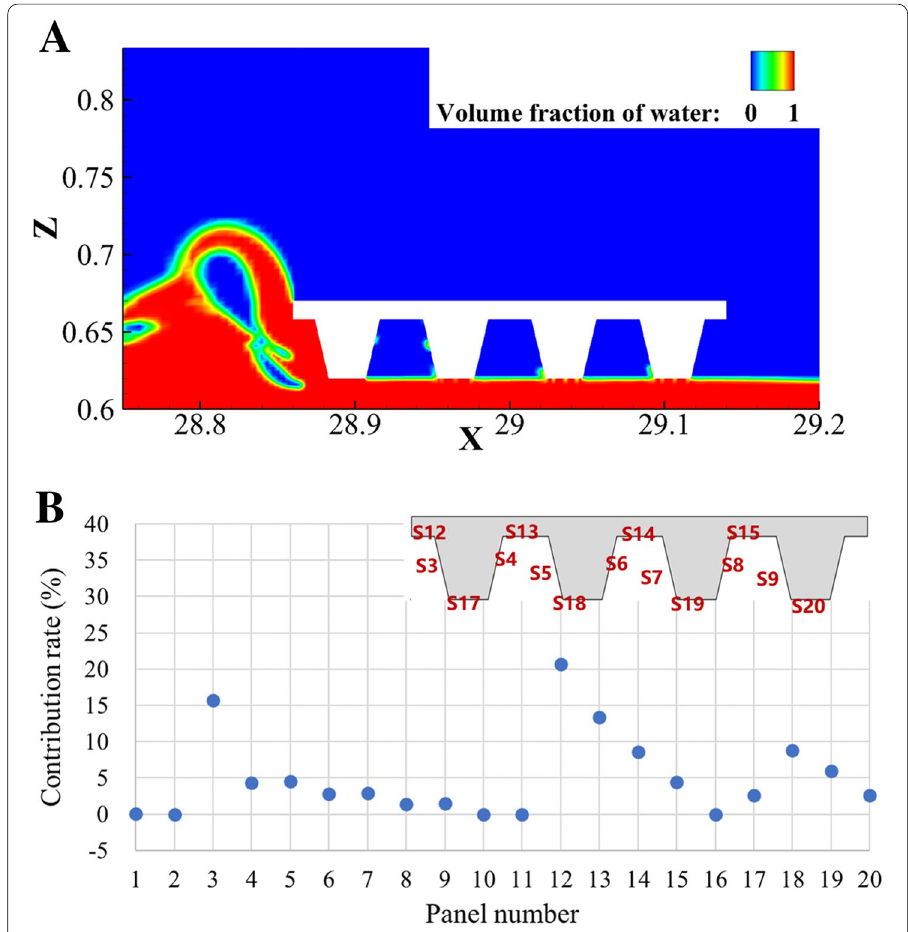
Fig. 17 Phase contour ( a ) and the contribution rate of each panel to the horizontal force at t